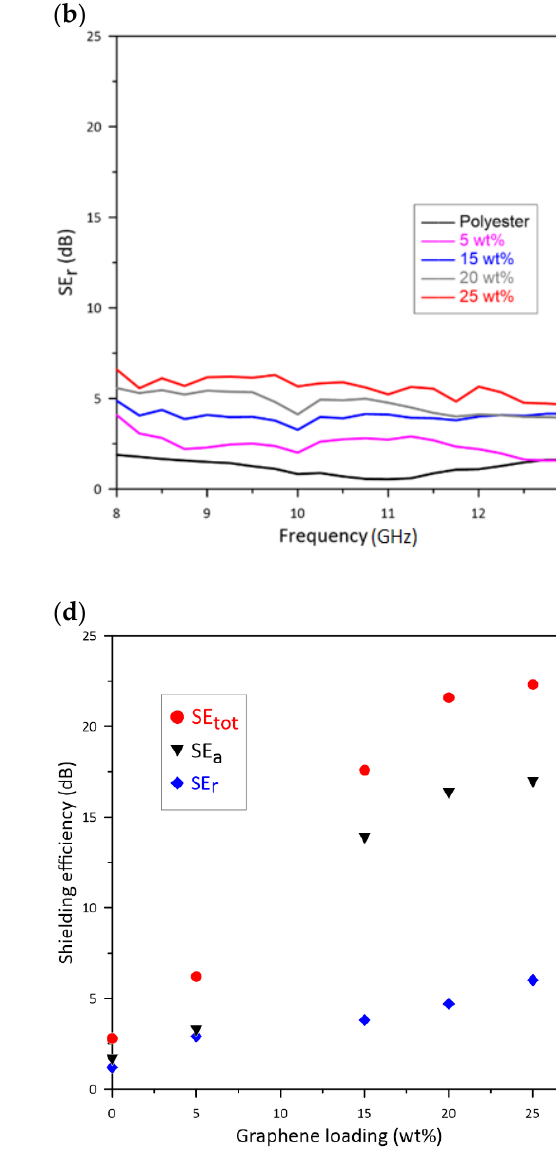
Figure 7. Plots of SE tot versus frequency for polyester composites filled with various graphene (Gr3X) contents; ( b , c ): SE r ( b ) and SE a ( c ) values of these polyester composites; ( a , d ) average values of SE tot, SE a, and SE r in the X-band frequency range are plotted versus graphene loading.